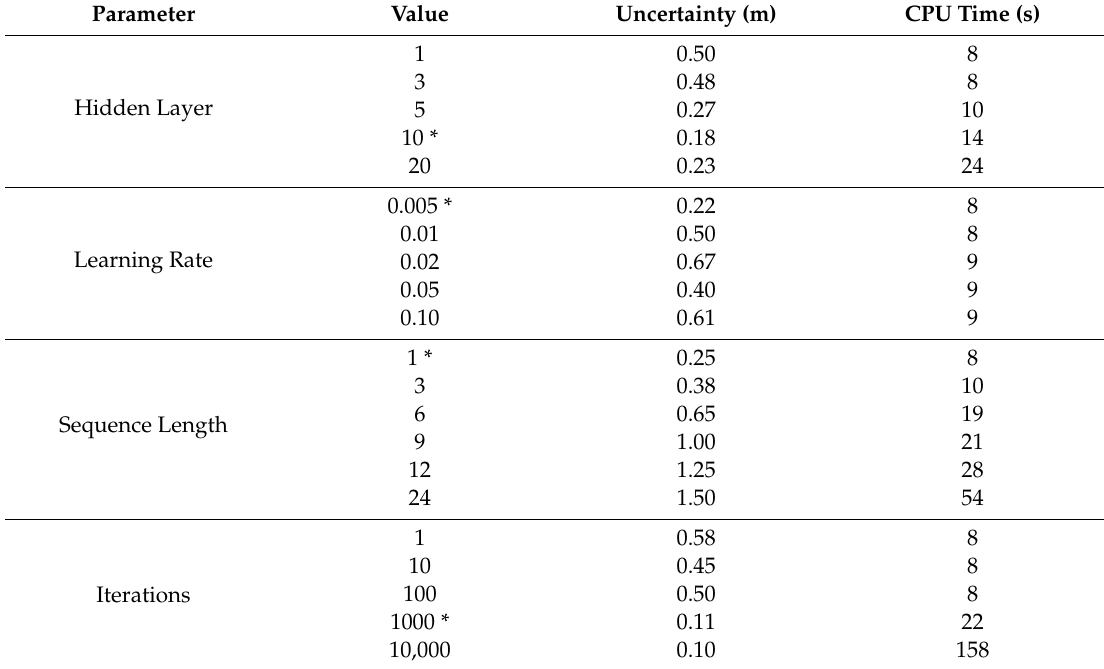
Table 5. Sensitivity analysis for